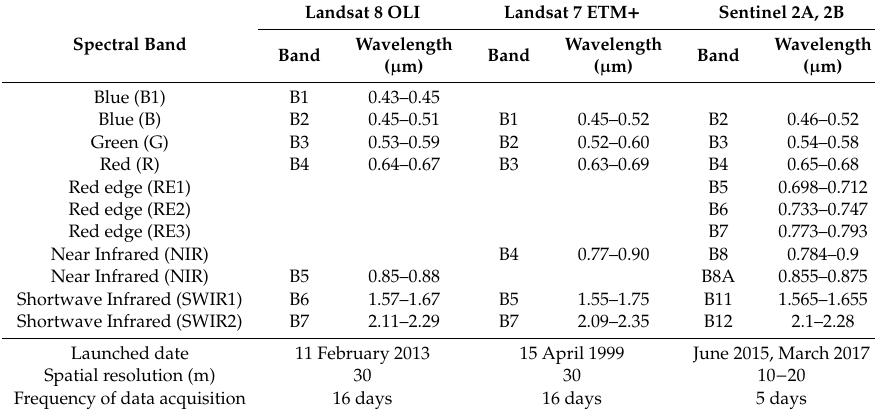
Table 1. Satellite sensors and spectral bands used in this study with their spatial and temporal resolutions.